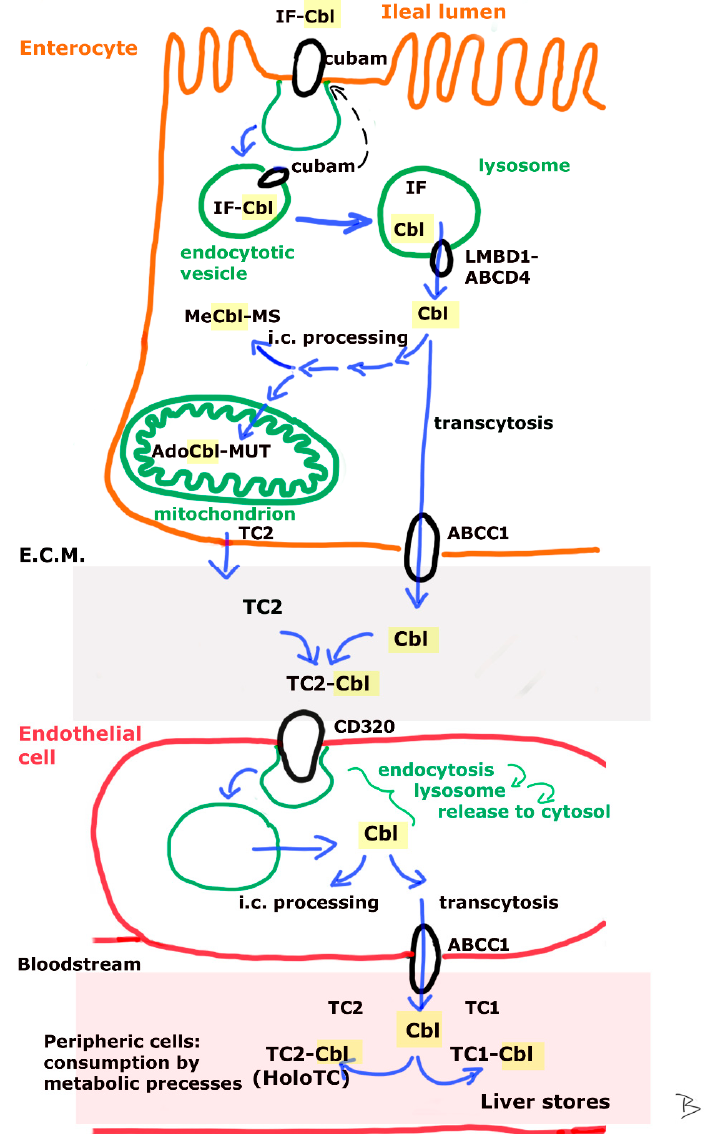
Figure 2. From absorption to distribution. The IF-Cbl complex is internalized after binding cubam (which is later recycled to the luminal membrane). In the endosome that is evolving to lysosome, the lowering of the pH makes IF dissociate from Cbl, which is then exported to the cytosol by the LMBD1-ABCD4 (lysosomal cobalamin transport escort protein complex—lysosomal cobalamin transporter ABCD4). Cytosolic free Cbl is either processed to active coenzymes for the enterocyte’s own metabolism or undergoes transcytosis, leaving the cell toward the extracellular matrix via ABCC1(ATP-binding cassette, subfamily C, member 1). Within the bloodstream it either takes the route of storage in the liver by binding TC1 (inactive vB12), or stays capable for uptake and utilization by the cells by binding TC2 (active vB12/holotrans-Cbl (HoloTC)). During absorption (Figure 2), the intrinsic factor (IF)-Cbl complex connects to its receptor cubam which is a heterodimer of the proteins amnionless and cubilin. The IF-Cbl complex is internalized by receptor mediated endocytosis. Later, cubam is recycled to the cell surface, while in parallel the pH of the vesicle turns acidic and becomes a lysosome. Low pH allows the dissociation of IF from Cbl, the released IF is degraded (reviewed by [9]). Intracellular trafficking from the lysosome to the cytoplasm involves the proteins LMBD1 and ABCD4. After its synthesis, ABCD4 protein is directed to the endoplasmic reticulum membrane, where it interacts with LMBD1 protein, this latter enabling the tran- sition of the LMBD1-ABCD4 complex to the lysosomal membrane. ABCD4 is the key